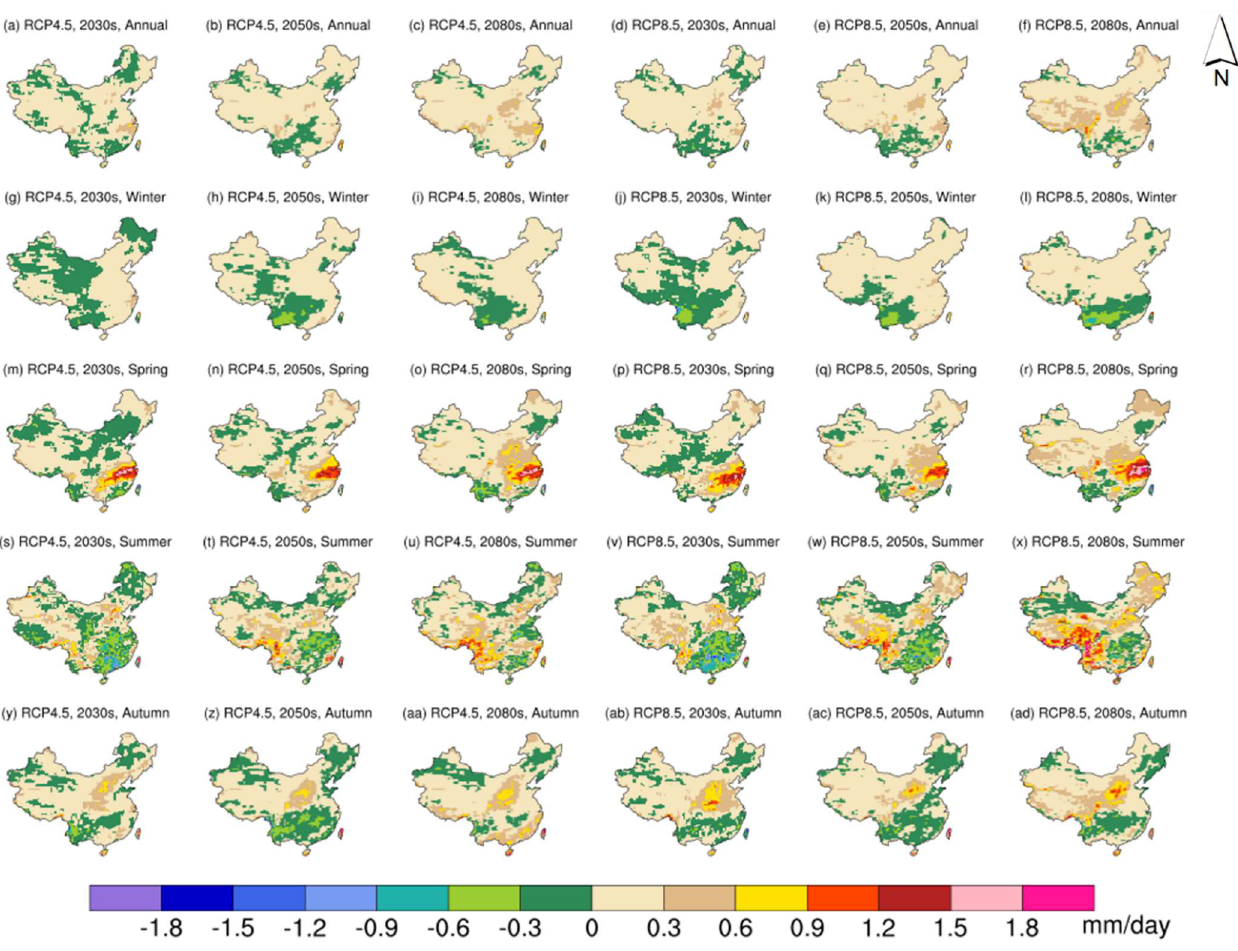
Figure 6. Projected changes in precipitation over China.